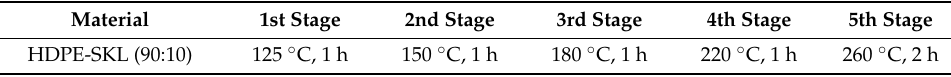
Table 7. Thermal stabilization experiments under argon atmosphere (flow rate 140 mL/min) without applied